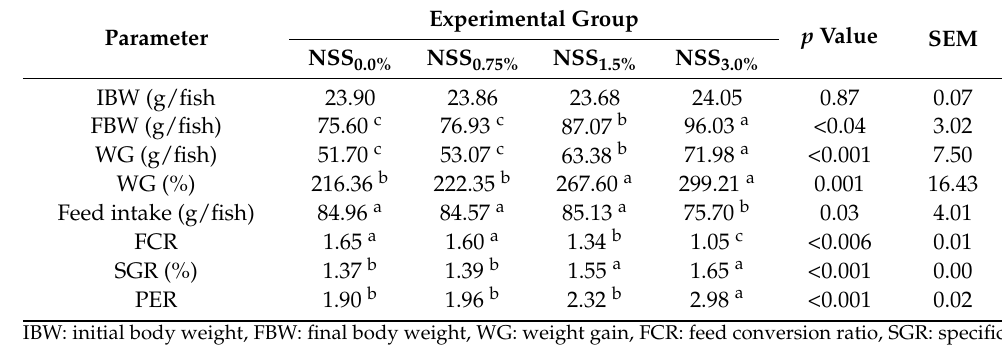
Table 3. Growth performance parameters of Nile tilapia ( O. niloticus ) fed diets enriched with different levels of a microalgae mix (NSS) containing Nannochloropsis oculate and Schizochytrium and Spirulina species at equal proportions (1:1:1) for 12